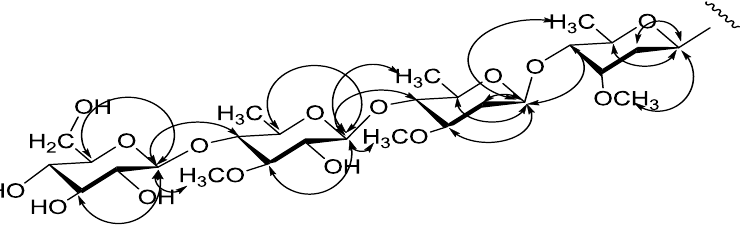
Figure 3. Key NOE of the sugars of 5 .